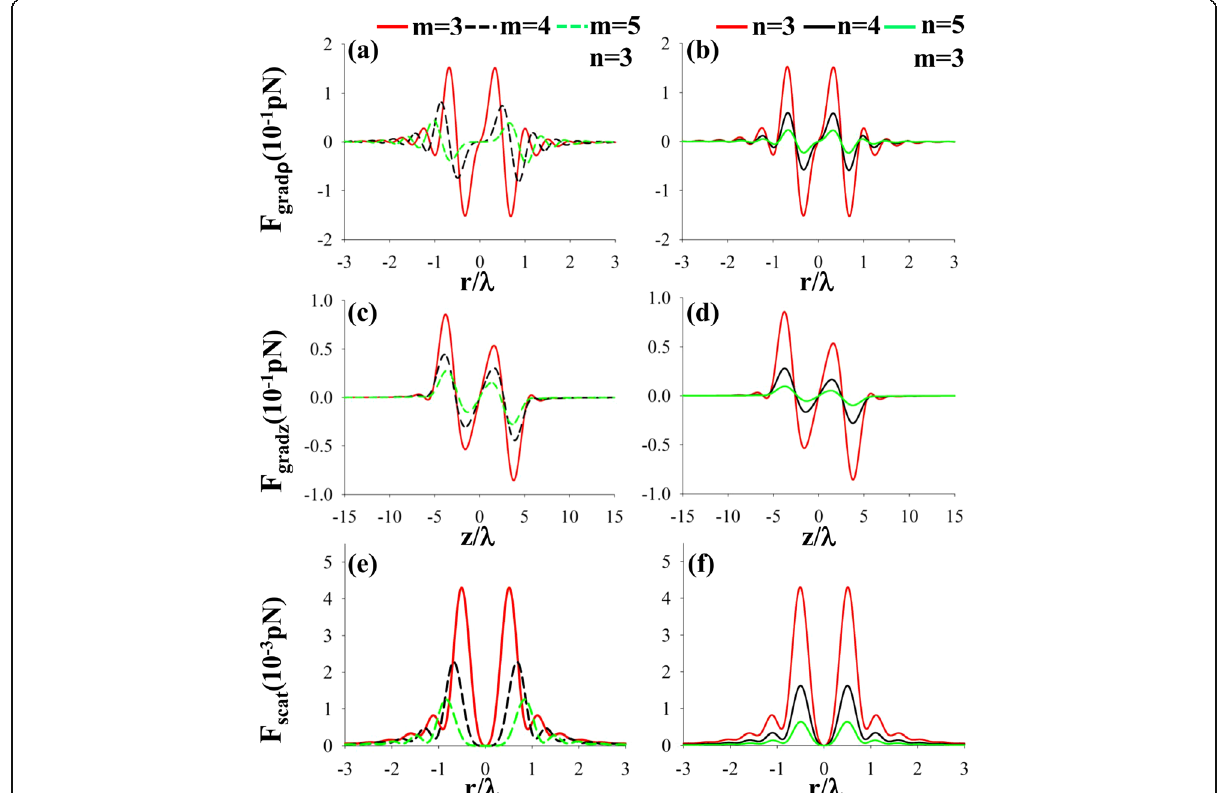
Fig. 6 a – f The radial, longitudinal gradient forces and scattering forces of a left-hand CPAVB after tight focusing on a high refraction index particle n p